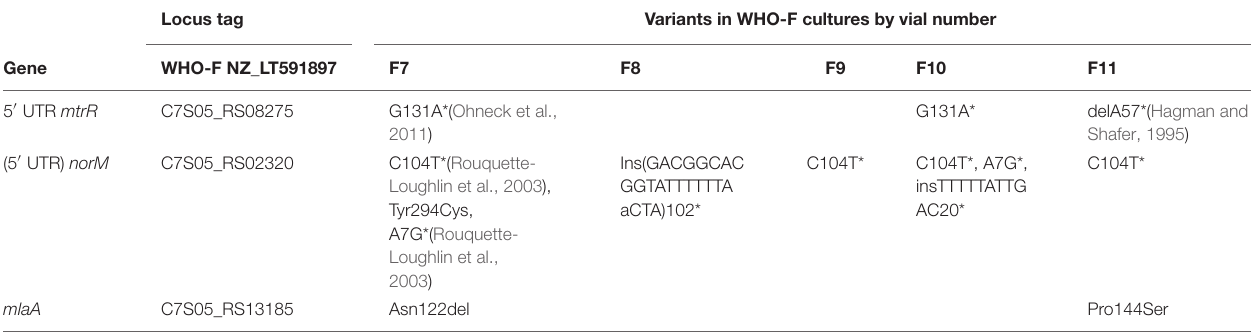
TABLE 1 | Variants occurring in at least 2 cultures of N.gonorrhoeae strain WHO-F exposed to chlorhexidine in the morbidostat set-up. Locus tag Variants in WHO-F cultures by vial